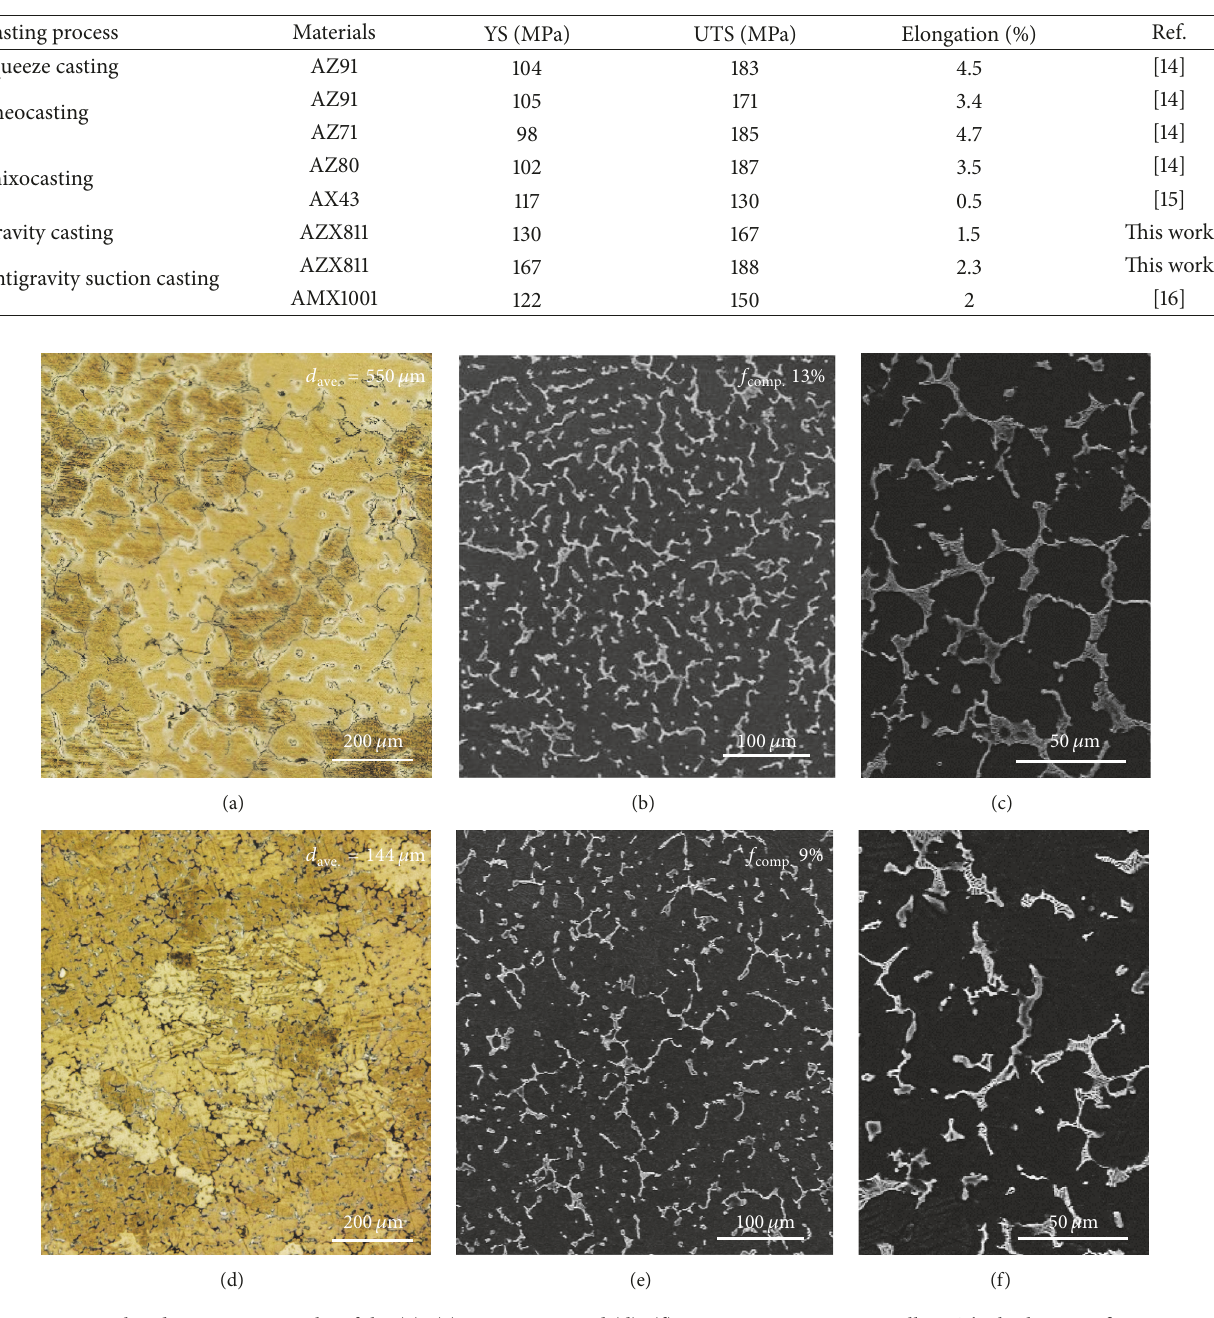
Figure 1: Optical and SEM micrographs of the (a)–(c) gravity-cast and (d)–(f) antigravity-suction-cast alloys. The high-magnification SEM micrographs are shown in (c) and